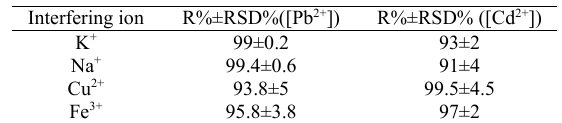
Table 2. The removal percentages of Cd 2+ and Pb 2+ ions in the presence of potassium, sodium, copper (II) and iron (III)